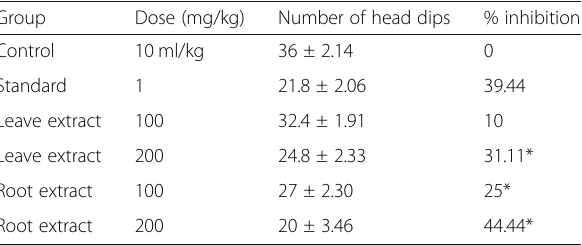
Table 3 CNS depressant activity test of C. turgida extracts by hole board